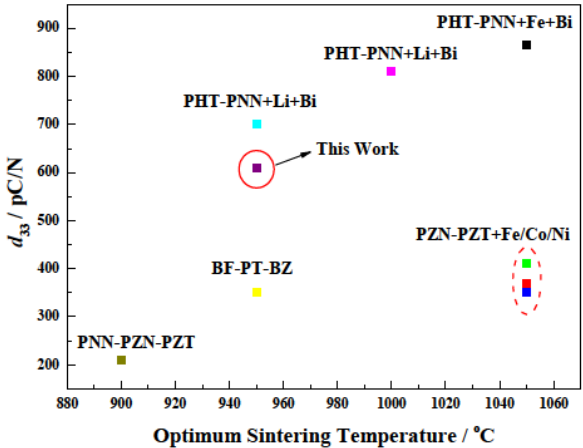
Figure 6: Piezoelectric properties of lead-based ceramics fabricated by low-temperature sintering